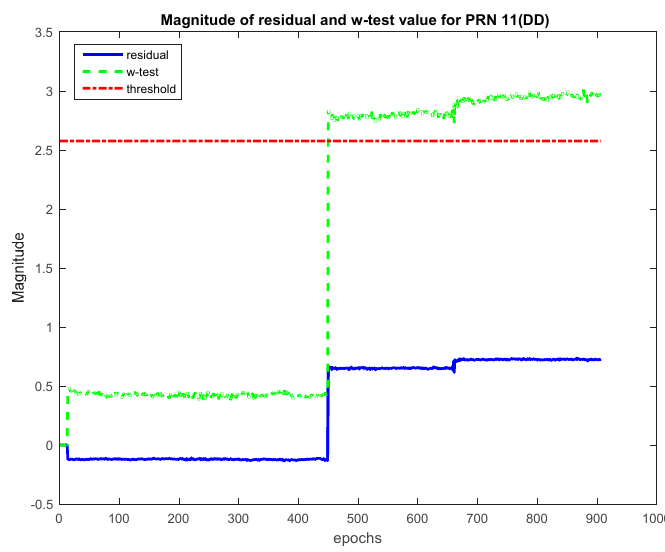
Figure 12. w -Test values for PRN 3 (Dataset 2).